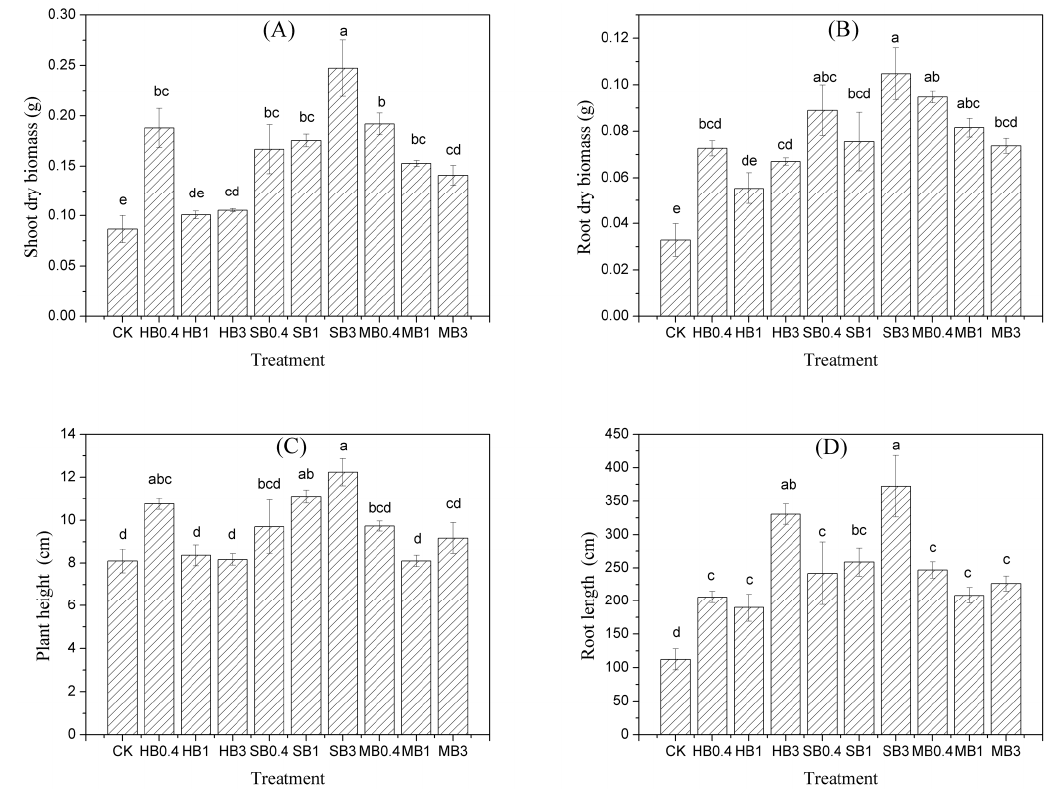
Figure 1. The effects of HB, SB and MB treatments on the plant growth. Shown are the ( A ) shoot biomass, ( B ) root biomass, ( C ) plant height and ( D ) root length of Cassia alata L. grown in mine tailings with different treatments. The vertical bars in the figures represent the standard errors of the means ( n = 3), Different letters indicate significant differences among different treatments at a significance level of 0.05. CK, HB/SB/MB0.4, HB/SB/MB1 and HB/SB/MB3 refer to no biochar input and the incorporation of biochar into the soil at 0.4%, 1% and 3% by mass, respectively. HB: Hibiscus